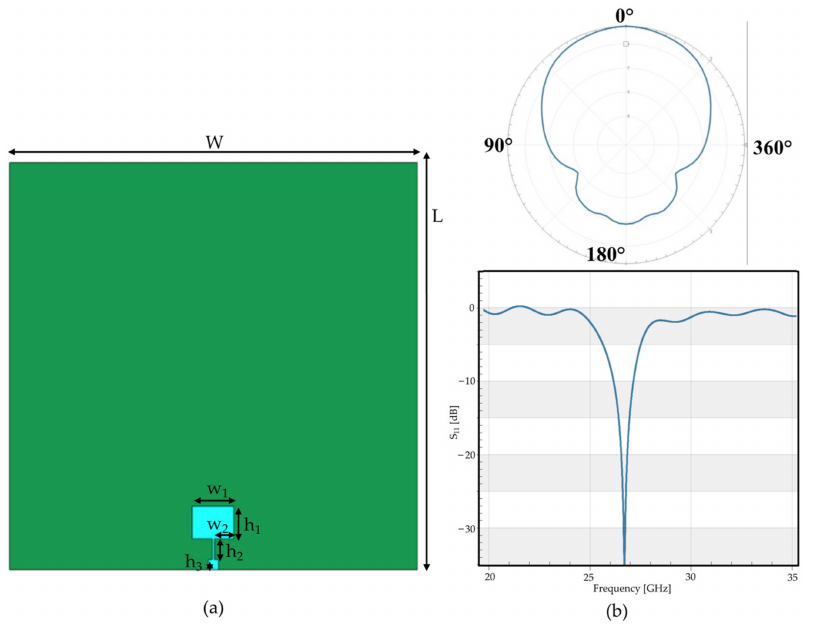
Figure 2. First wearable patch antenna simulated, tuned to f = 26.5 GHz: ( a ) geometry of the antenna: front view; ( b ) performances of the antenna in terms of, in the upper part, radiation pattern ( ϕ = 0 ◦ ) and, in the lower part, the reflection coefficient (S 11